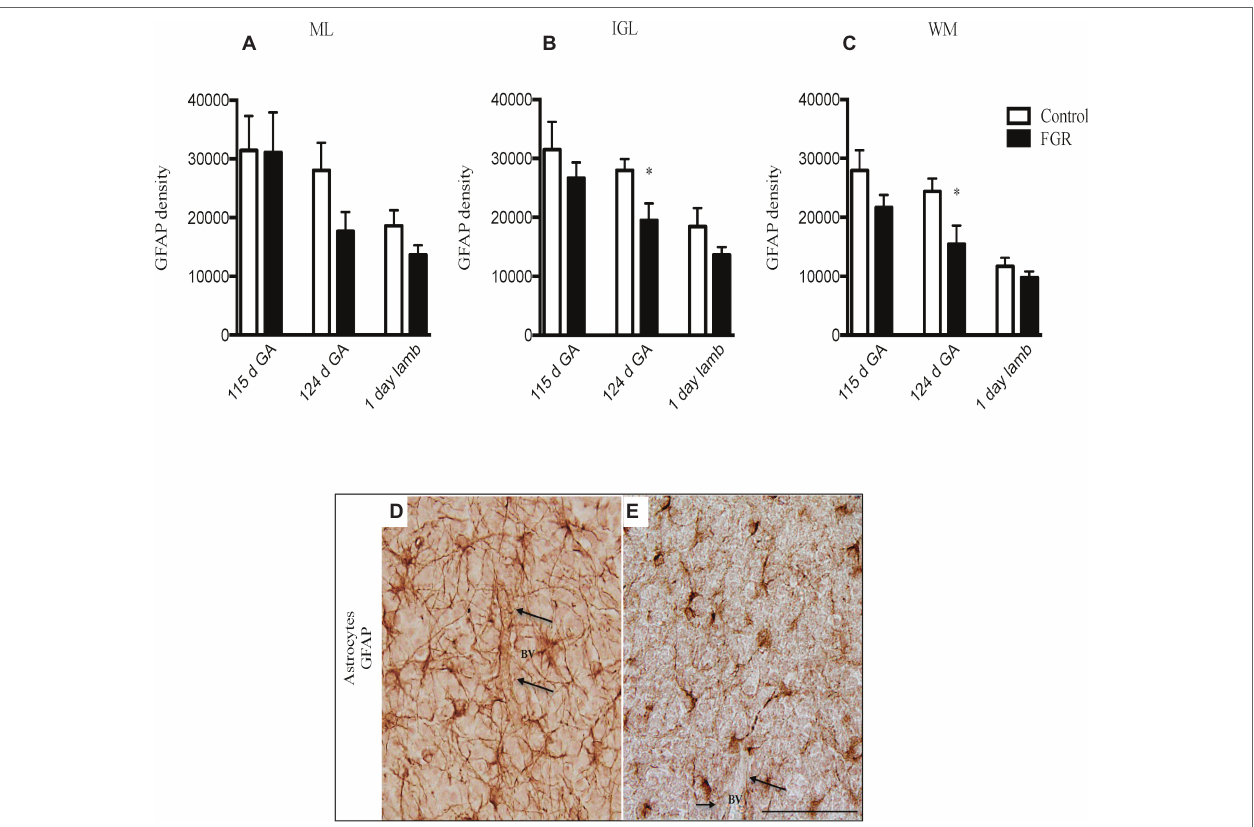
FIGURE 3 | Glial fibrillary acidic protein (GFAP) density in the molecular layer [ML (A) ], internal granular layer [IGL (B) ], and white matter [WM (C) ] in the fetal brain at 115 d GA, 124 d GA, and 1-day-old lamb of control and FGR animals. Comparisons are made within the same brain region at the same gestation and not across regions or across gestation. Each bar represents the mean ± SEM; * p ≤ 0.05. Representative micrographs showing GFAP-positive immunoreactivity in the fetal IGL at 124 d GA of control (D) and FGR (E) brain. Arrows pointing to a blood vessel (BV), showing the damaged astrocytic end-feet. FGR, fetal growth restriction. Scale bar = 50